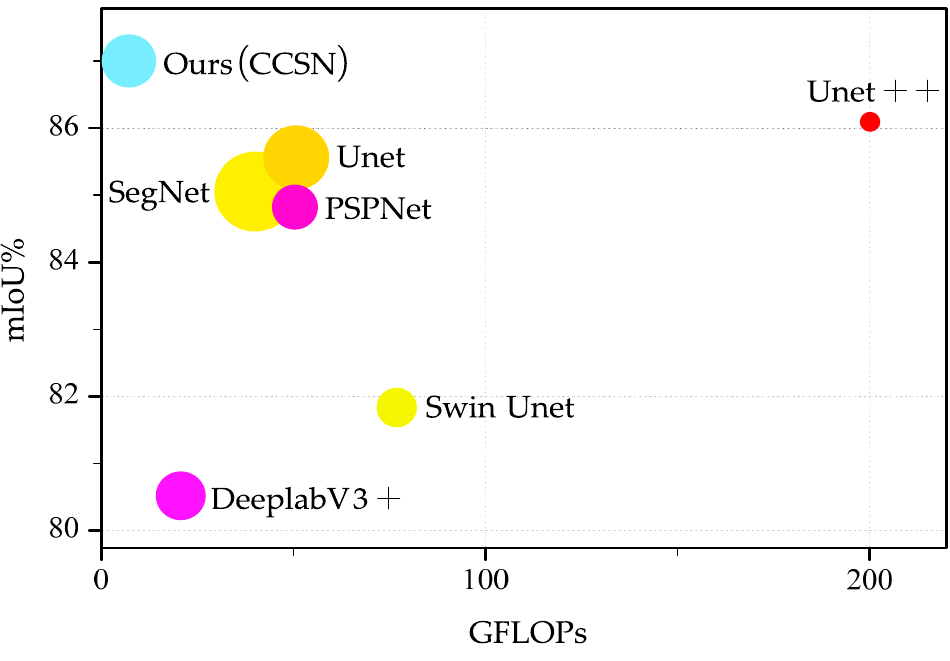
Figure 1. Inference mIoU, FLOPs, speed, and storage performance on our dataset. The bigger the circle, the faster the speed. The redder the color, the larger the storage.